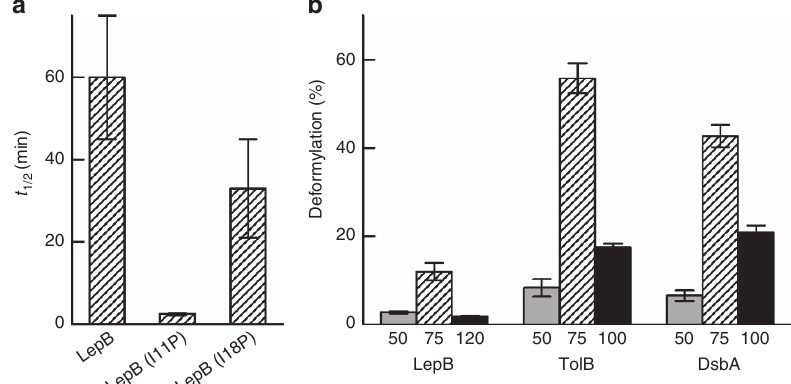
Figure 2 | Deformylation of RNC variants. ( a ) Influence of proline substitutions in LepB75-RNC. Time courses of deformylation of LepB-, LepB(I11P)- and LepB(I18P)-RNC were measured and analysed as in Fig. 1b, and values of t 1/2 are plotted. ( b ) Dependence of deformylation on the length of the nascent peptide. PDF assays with RNCs carrying nascent peptides of 50, 75 or 100/120 amino acids were performed as in Fig. 1b. The extent of deformylation after 30min incubation with PDF is plotted. Error margins represent s.e.m. ( n ¼ 2). NATURE COMMUNICATIONS|8:15562|DOI: